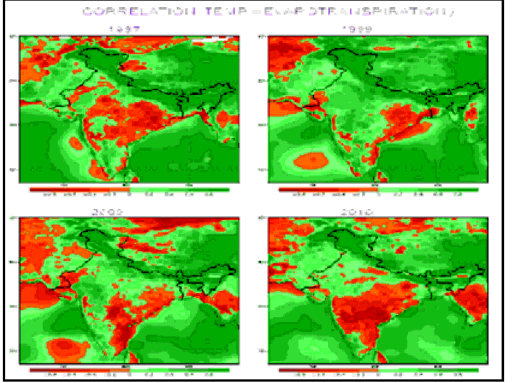
Figure 4. Correlation between temperature (K) and evapotranspiration (mm/day) ρ (E, T) using CLM scheme for El Niño (1987,2009), La Niña (1999,2010) years.